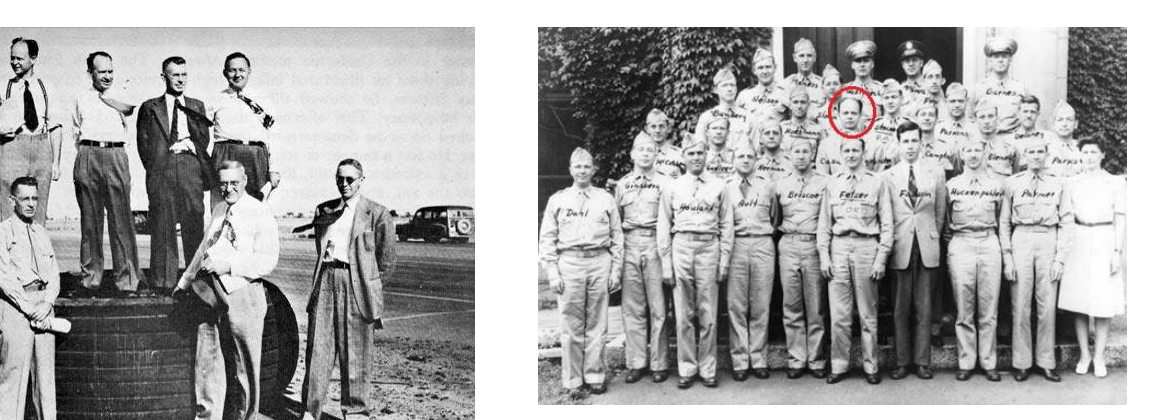
Figure 7. Casagrande (in the center with a red circle) with his stu- dents of the first course in the School of Soil Control of the Ameri- can army, in